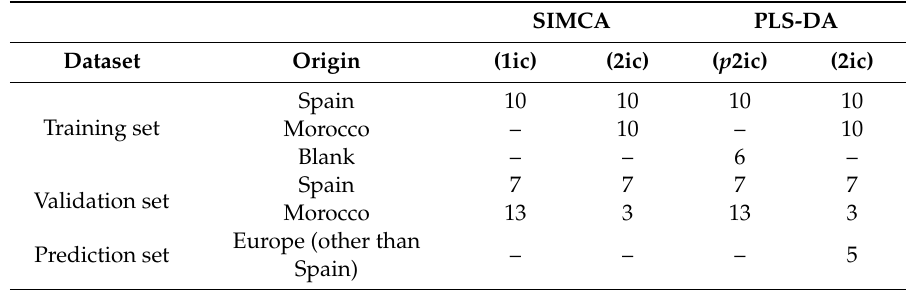
Table 2. Distribution of the samples used in the di ff erent classification datasets regarding geographical origin.